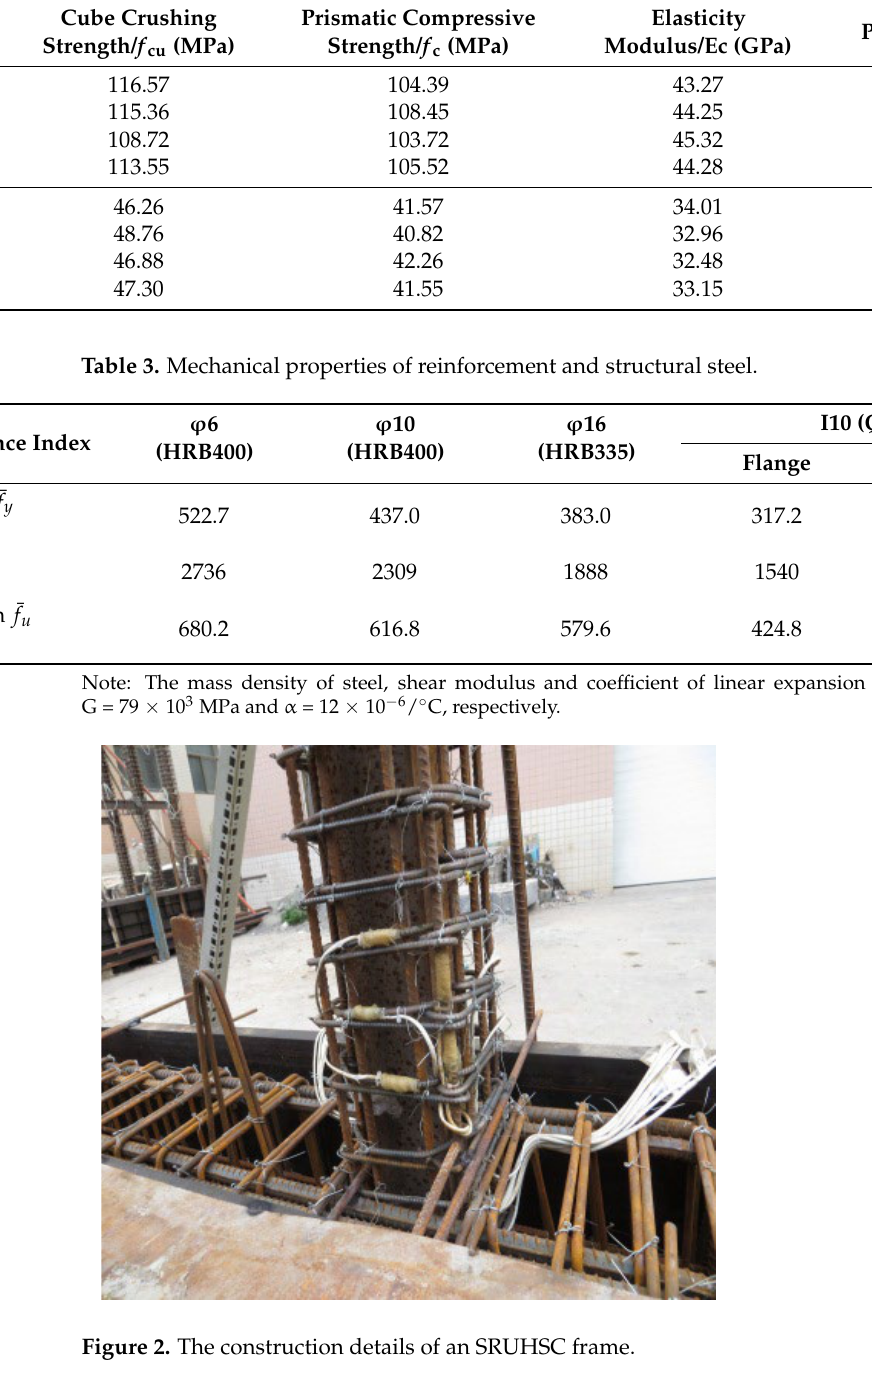
Table 2. Mechanical properties of concrete.